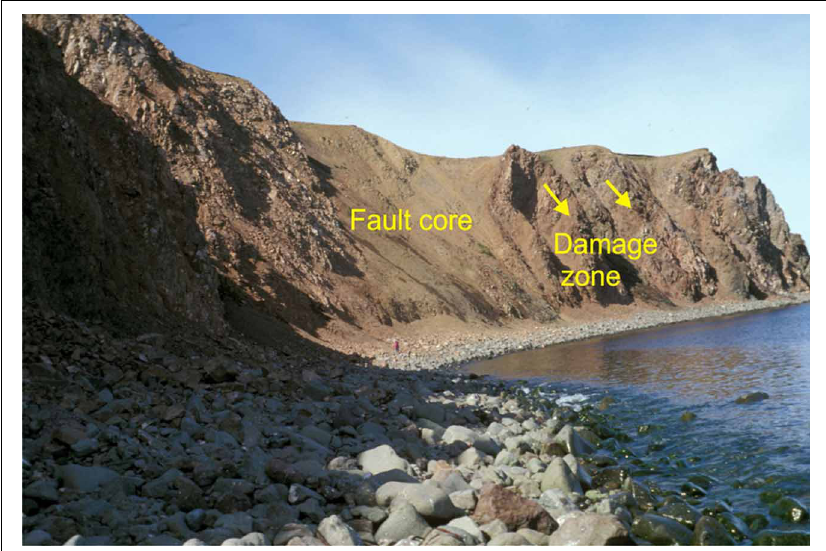
FIGURE 3 | Seismic and aseismic slip. Fault zones are composed of a core and a damage zone. View west, the core and the damage zone of a part of the Husavik-Flatey transform fault, which is partly exposed on land in North Iceland (Gudmundsson, 1995, 2000). The core is 10m thick and the lava flows in the damage zone, originally sub-horizontal, now dip 40 ◦ NW. The core is composed of soft breccia and presumably subject to much aseismic slip, whereas the fault as a whole is seismically highly